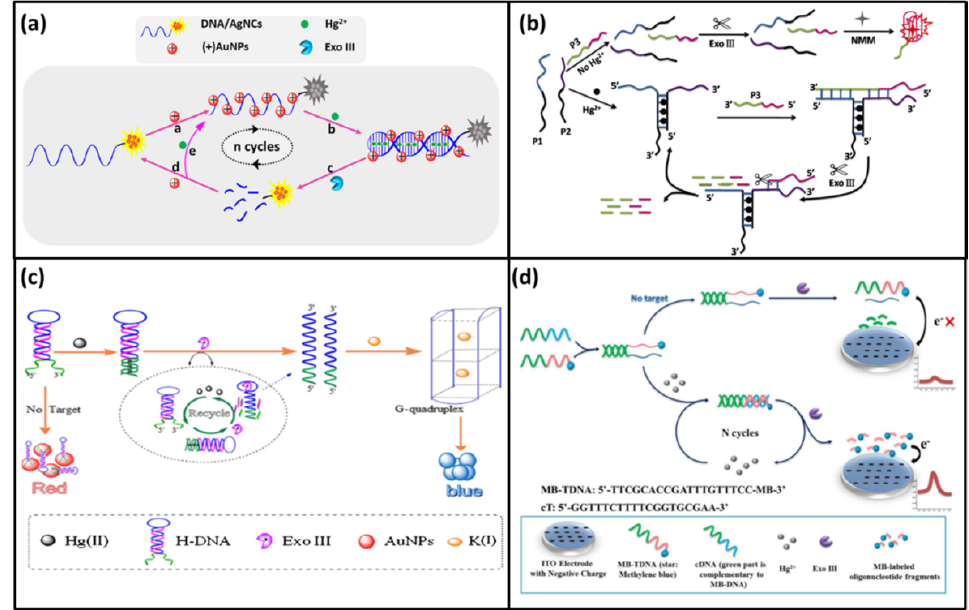
Figure 2. ( a ) A scheme of fluorescence DNA biosensor to detect Hg 2+ based on Exo III-assisted signal amplification and silver nanoclusters. Reprinted with permission from [43]. Copyright 2019 Springer Nature. ( b ) A scheme of a label-free fluorescence DNA biosensor for detection Hg 2+ based on Exo III-aided signal amplification and G-quadruplex DNA [26]. ( c ) A scheme of a colorimetric DNA biosensor for the detection of Hg 2+ using Exo III-assisted signal amplification and AuNPs. Reprinted with permission from [46]. Copyright 2017 Springer Nature. ( d ) A scheme of a homogeneous electrochemical DNA biosensor for Hg 2+ determination based on Exo III-assisted recycling amplification and indium tin oxide (ITO) electrode. Reprinted with permission from